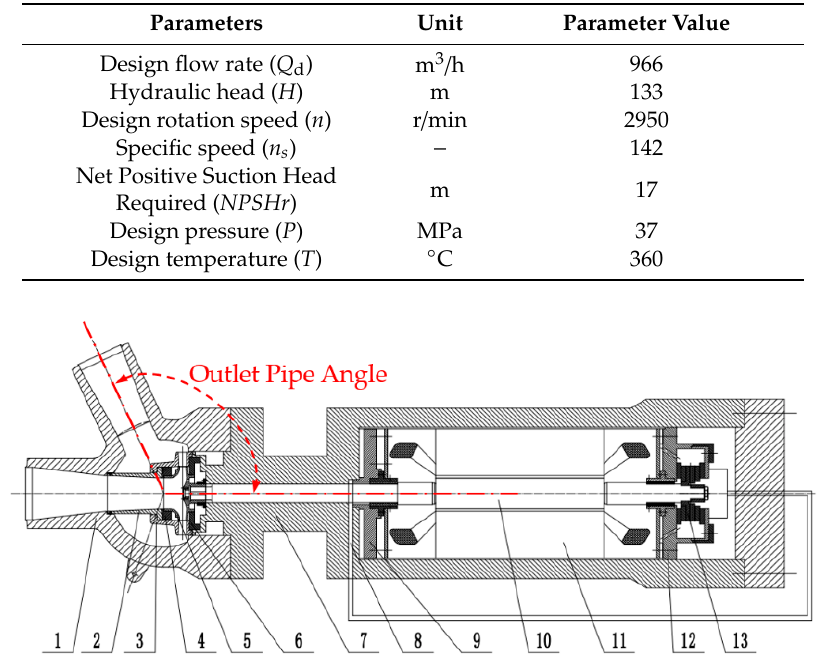
Figure 1. Structure of boiler circulating pump. 1 Pump casing; 2 connecting body; 3 guide vane; 4 front seal ring; 5 impeller; 6 rear seal ring; 7 motor housing; 8 cooling circuit; 9 front bearing seat; 10 rotor; 11 stator; 12 rear bearing seat; 13 thrust disk.